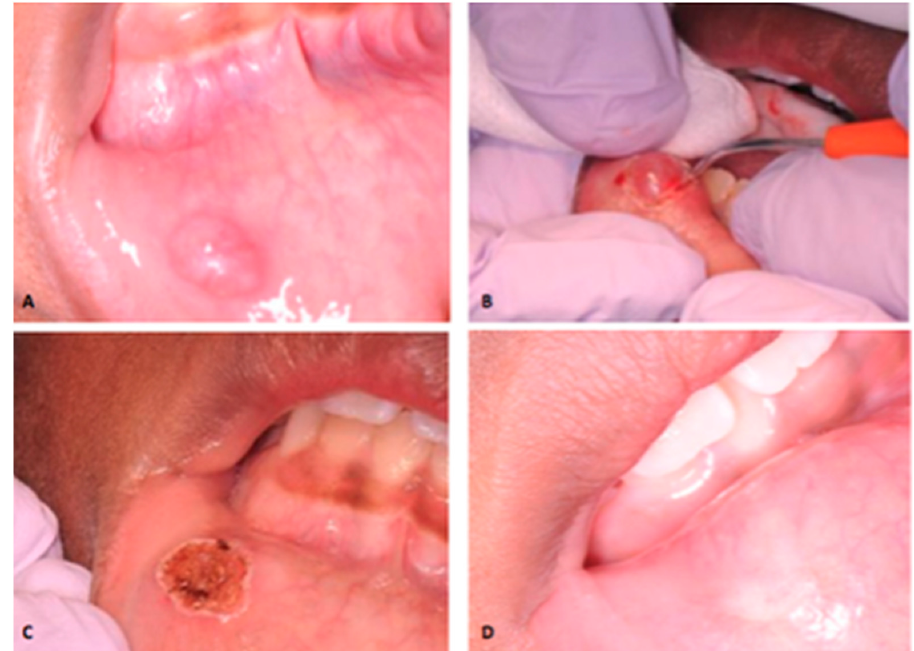
Figure 1. Laser removal of mucocele of the lower lip in an eight years old female. ( A ) Initial clinical presentation. ( B ) Removal of mucocele by use of high-intensity diode laser. ( C ) Immediate postoperative view. ( D ) Clinical appearance after one month.